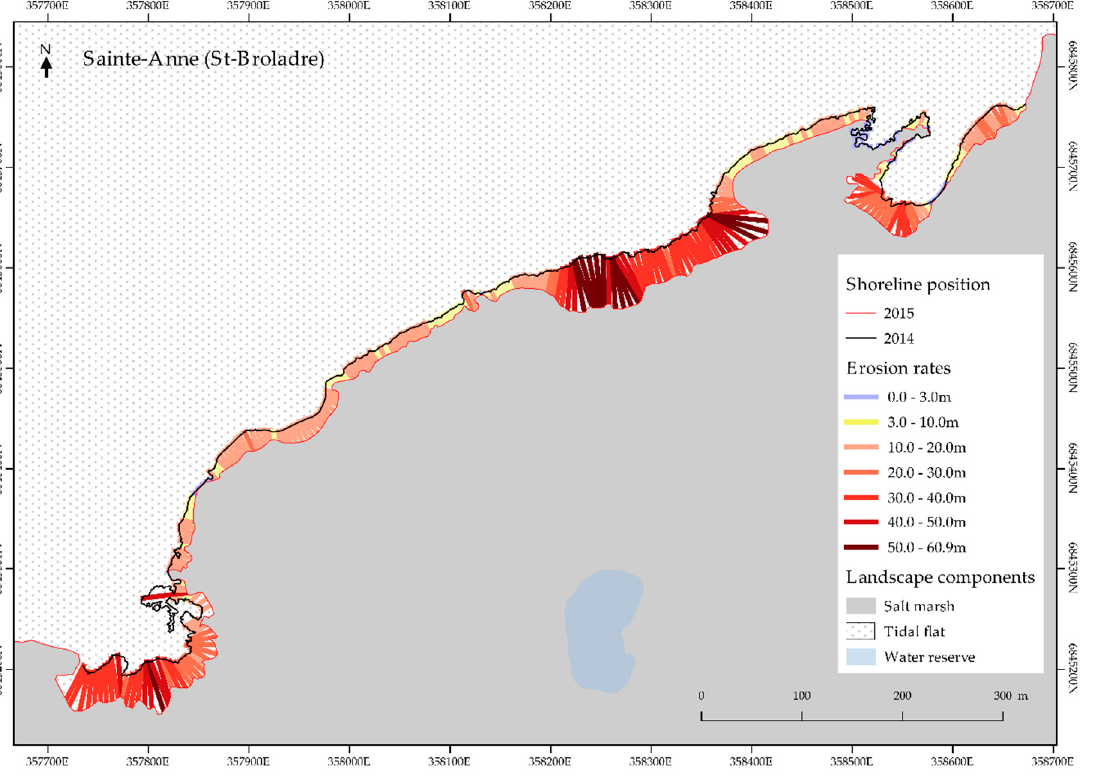
Figure 7. Mapping of the erosion rates in Sainte-Anne site.